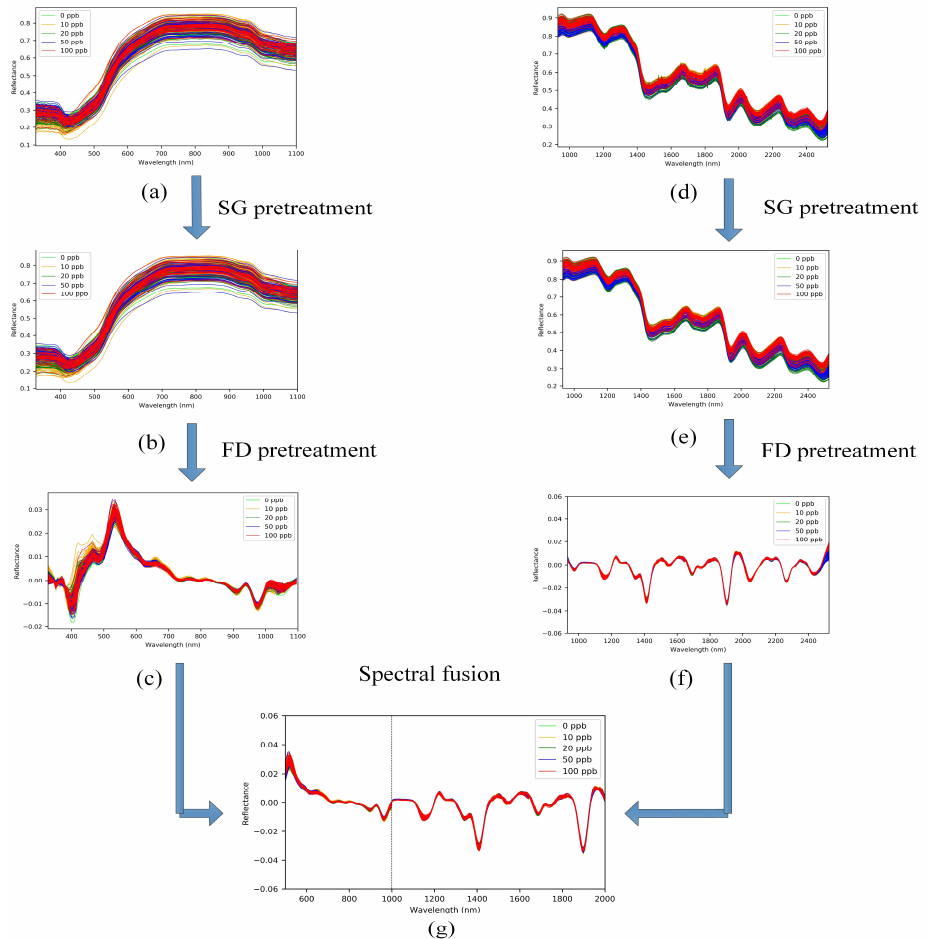
Figure 3. Waveforms before and after spectral pretreatment. ( a ) Raw spectra in Vis-SWNIR, ( b ) Vis-SWNIR spectra after SG, ( c ) Vis-SWNIR spectra after SG–FD, ( d ) Raw spectra in LWNIR, ( e ) LWNIR spectra after SG, ( f ) LWNIR spectra after SG–FD, and ( g ) Spectra after fusion.